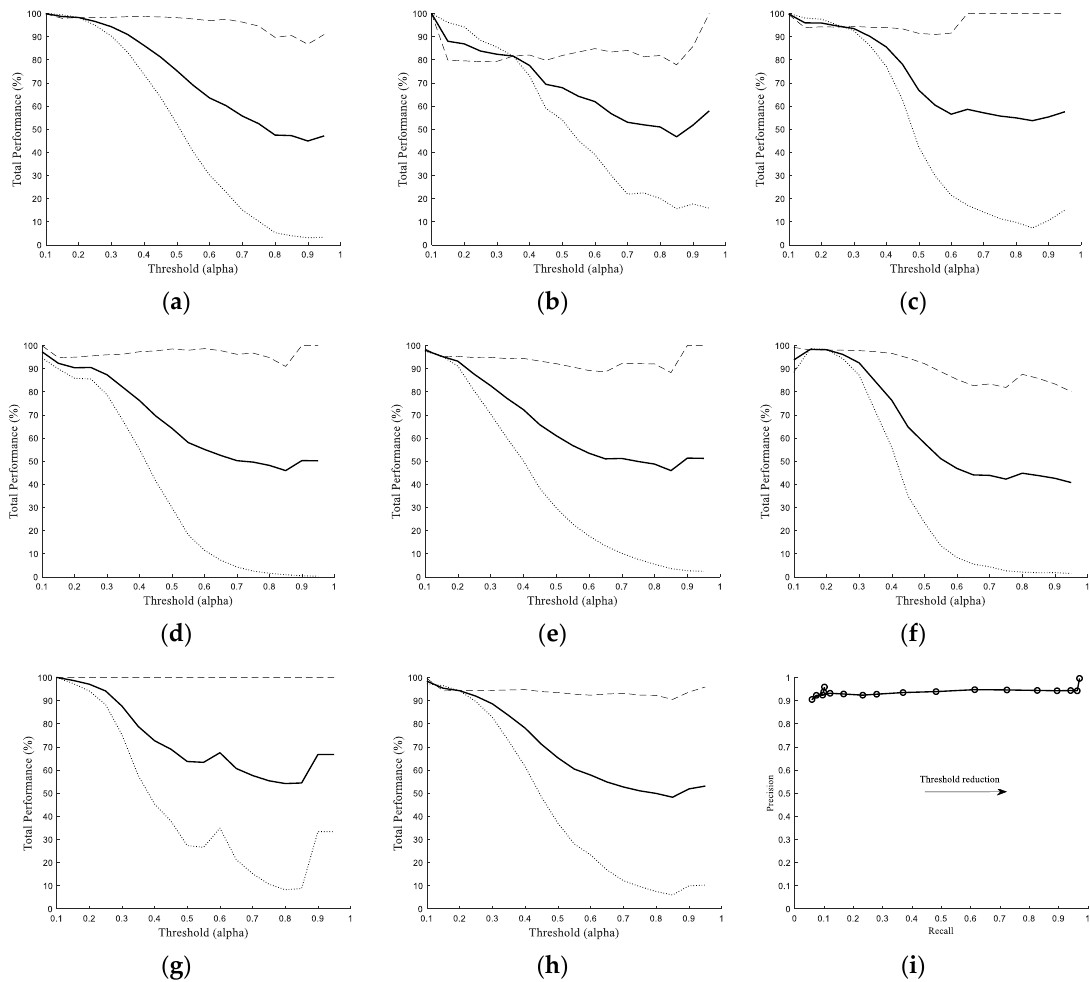
Figure 5. Fourier analysis and Type-I fuzzy classifiers (FFT-Type-1 FLC) classifier performance over different λ 2 thresholds for seven fetal sheep (sheep a – g ). Band-pass: 80 – 120 Hz. Dotted lines: sensitivity, dashed lines: selectivity, bold lines: overall performance. ( h ) is the overall performance of the classifier for 7 sheep. ( i ) Precision – recall curve showing the overall performance. Table 2. Performance of the FFT-type-1-FLC classifier using the band-pass frequency of 80 – 120 Hz indicated for the best threshold value.